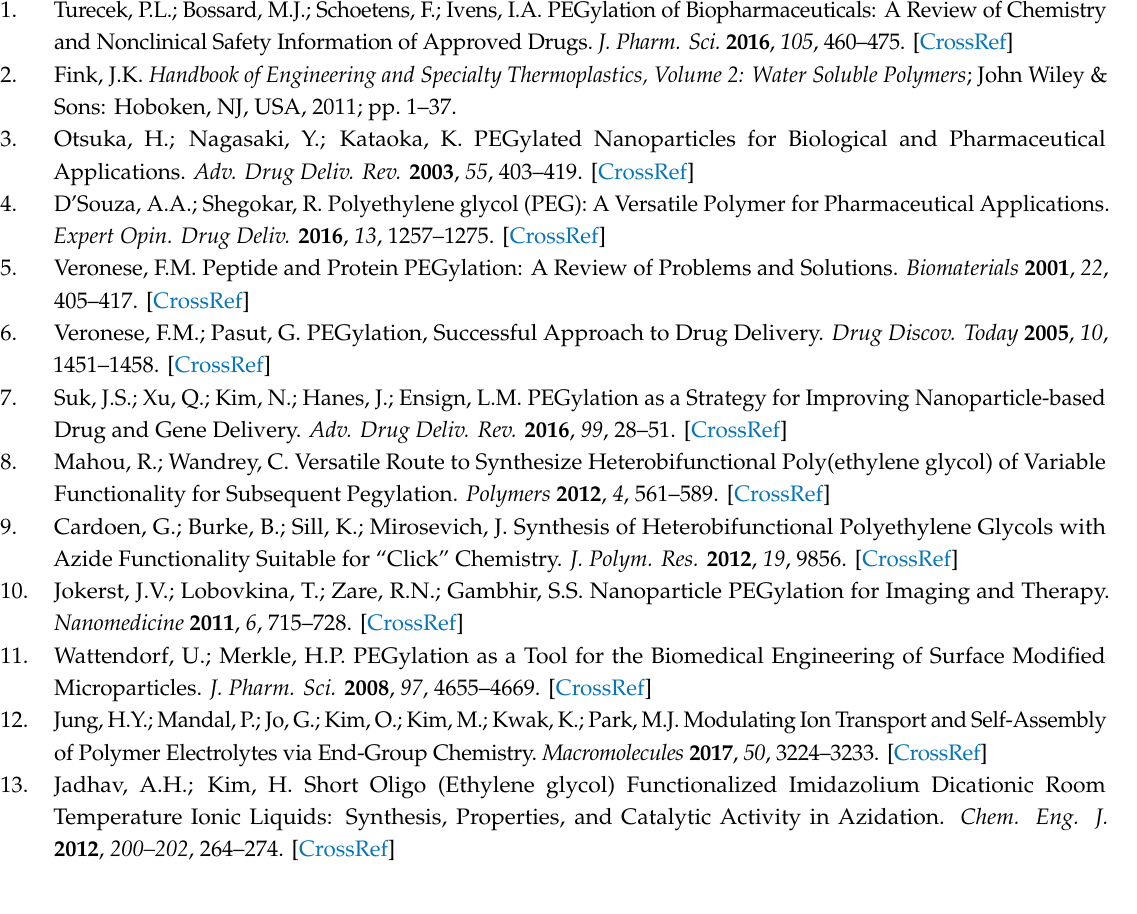
Figure S1: 1H NMR spectra of MsO-PEG400-OMs and mPEG550-OMs, Figure S2: 1H NMR spectrum of NH2-PEG400-NH2, Figure S3: DSC curves of mPEG 2400 -N 3